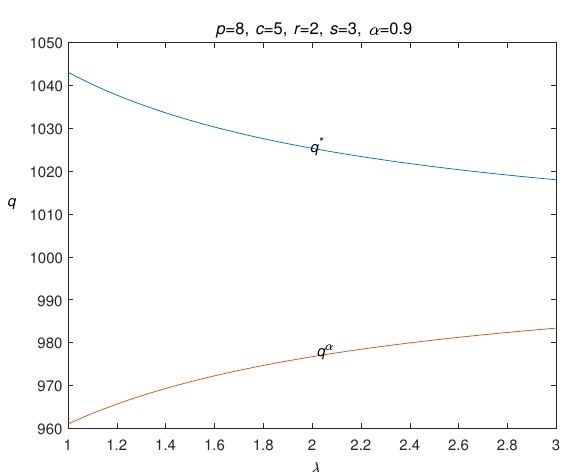
Figure 8. Optimal order quantities q ∗ and q α with different loss aversion coefficients λ